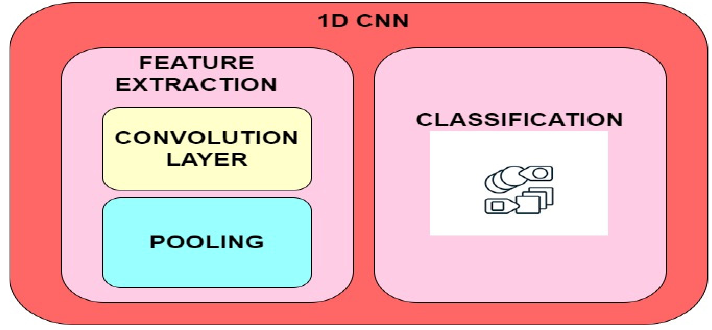
Figure 2. Major components of the 1D